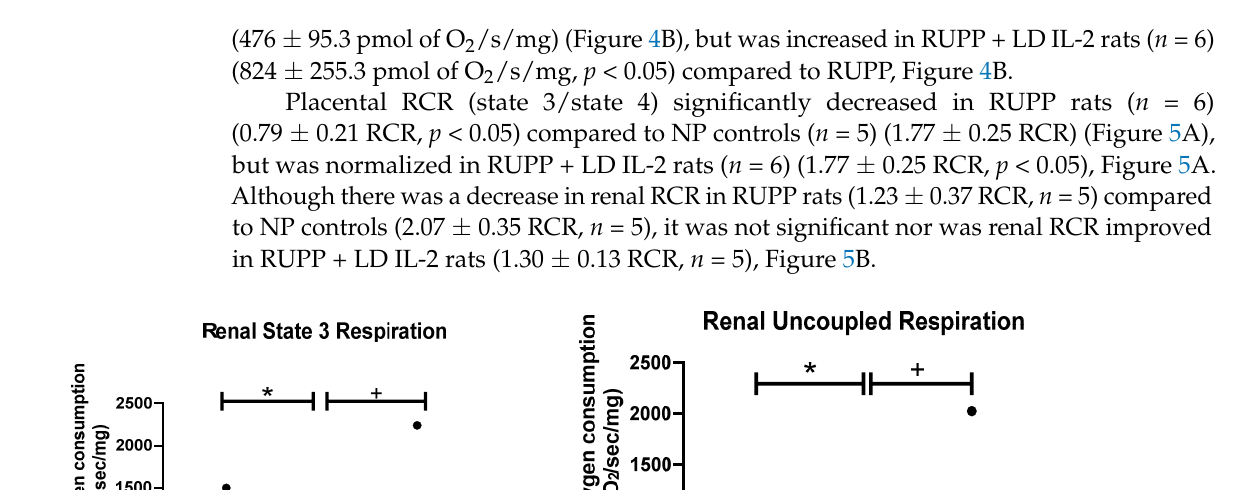
Figure 4. ( A ) State 3 and ( B ) uncoupled renal mitochondrial respiration were reduced in RUPP rats ( n = 5) compared to NP rats ( n = 5), but were normalized in RUPP + LD IL-2 rats ( n = 6). Results were reported as means ± SEM and considered statistically significant when p < 0.05. (* p < 0.05 vs. NP control; + p < 0.05 vs. RUPP).